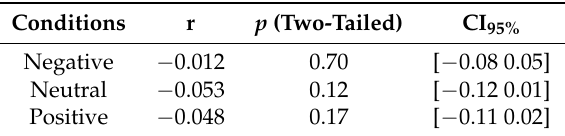
Table A13. Bootstrap (10,000 simulation runs) 95.0% CI associated with the Spearman correlation between PE6s (i.e., 62 PE6s associated with 62 EEG channels of a participant, per affect) and DEs (i.e., 62 DEs associated with 62 EEG channels of a participant, per affect) in the negative, neutral, and positive mental states.